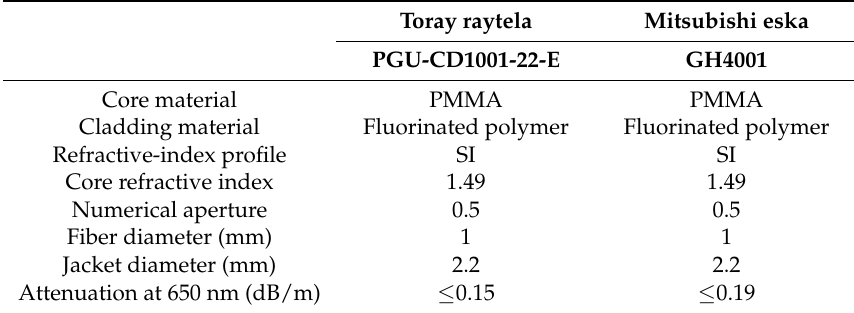
Table 1. Main mechanical and optical characteristics of the fiber samples. PMMA = poly(methyl methacrylate); SI =